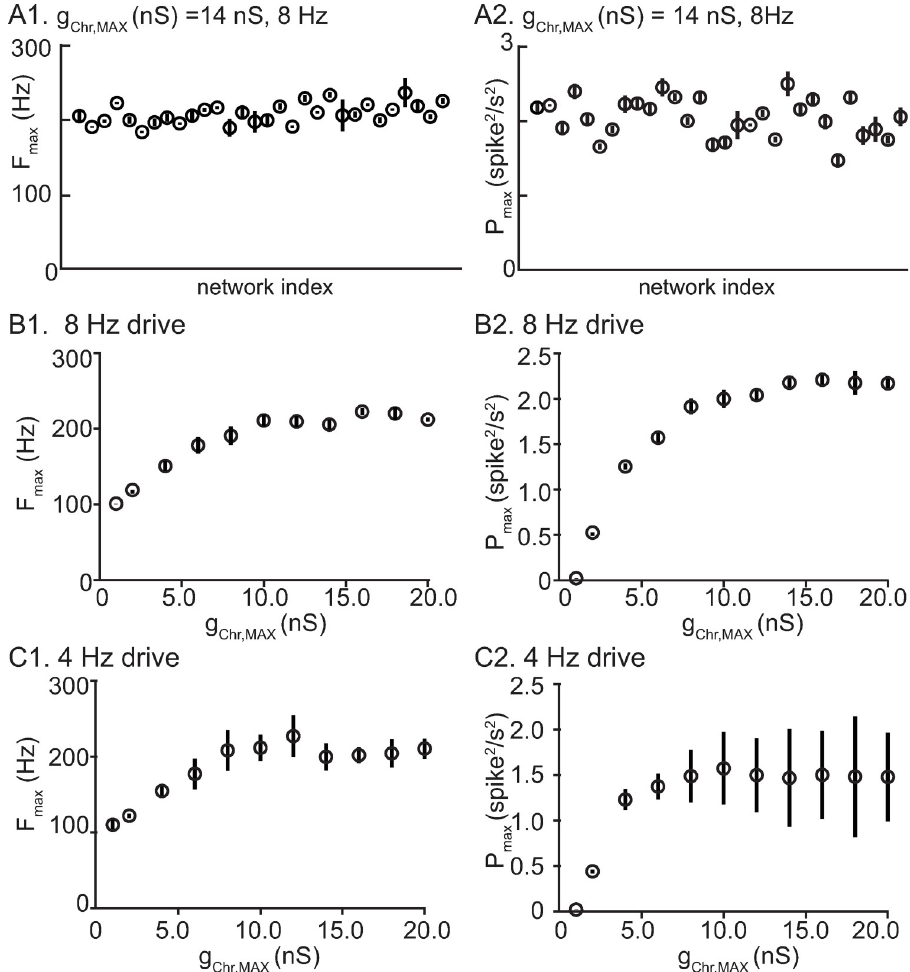
Fig 7. Performance of network with hyperpolarizing synapes is robust to different instantiations of network connectivity. A . Distinct random network instantiations with constant drive amplitude and frequency. Vertical lines give the standard deviation within a network across theta cycles. A1 . Fast frequency with the most wavelet power for each network. A2 . Maximum power. B . Same network, variable amplitude 8 Hz drive. B1 . Frequency with max power. B2 . Maximum power. C . Same network, variable amplitude 4 Hz drive. C1 . Frequency with max power. C2 . Maximum power. For B and C, vertical lines give the standard deviation for 15 network instantiations across all theta